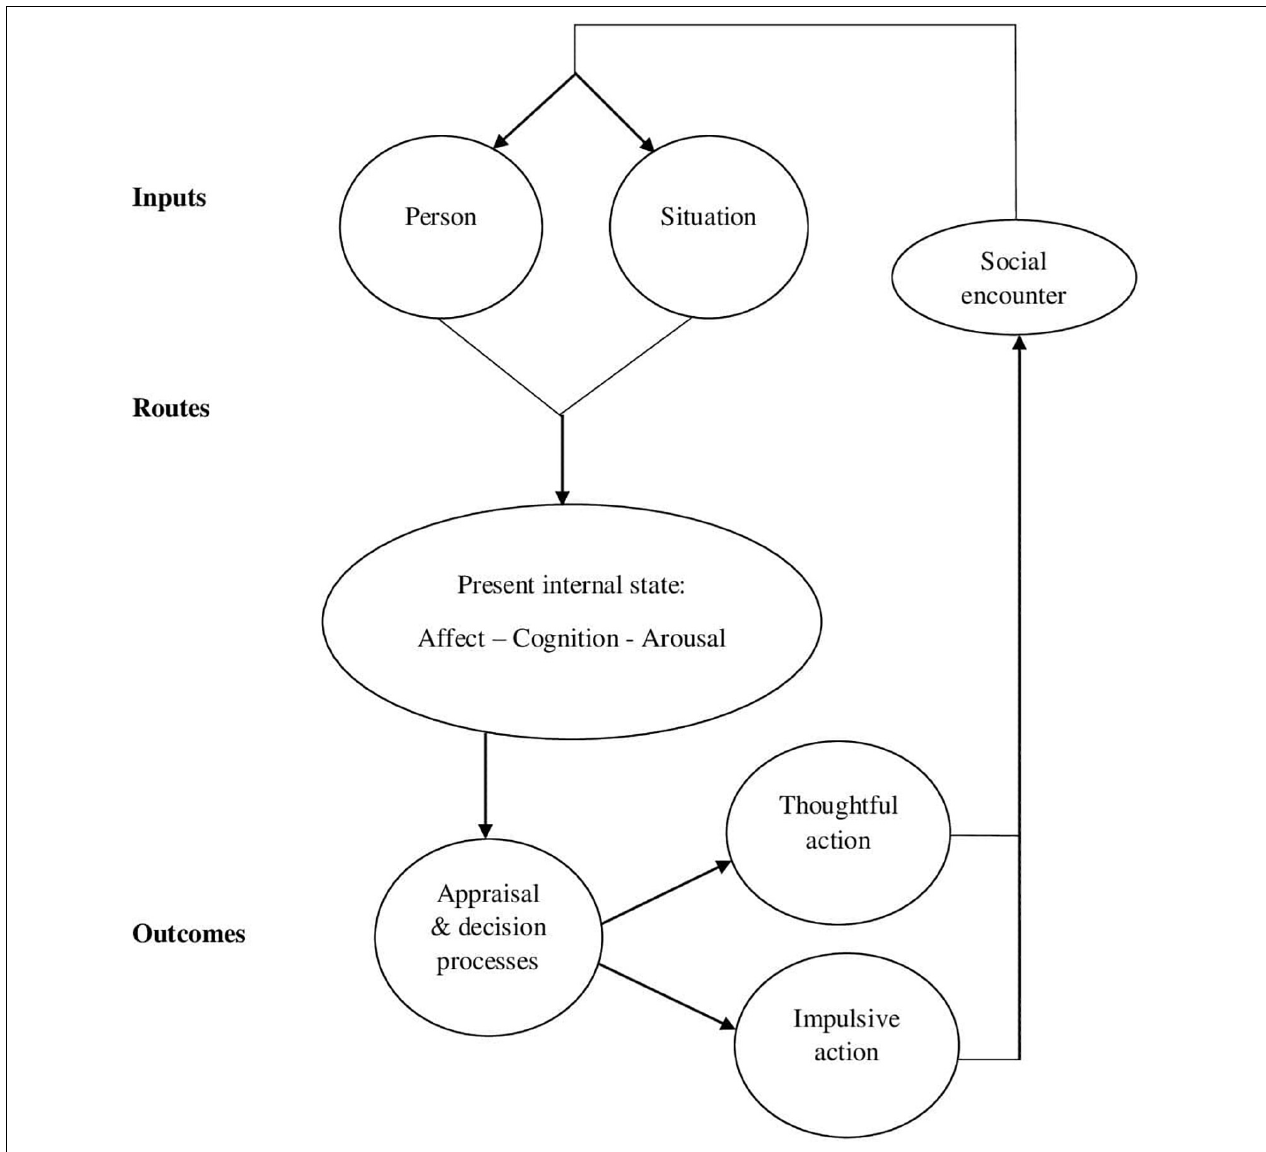
FIGURE 2 | General Aggression Model. This figure highlights the proximal process of aggression in the General Aggression Model. The proximal process occurs in three stages: Inputs, routes, and outcomes. First, in the input stage, person-related factors and situations act as inputs which, in the routes stage, activate certain emotions, cognitions and arousals in the individual. The person’s internal state then affects appraisal and decision-making processes in the outcome stage, leading to them engaging in either a thoughtful action or impulsive action, such as aggression. This behavioural outcome impacts the individual’s social encounter and feeds back into person and situation related factors through learning mechanisms, thus perpetuating the model’s